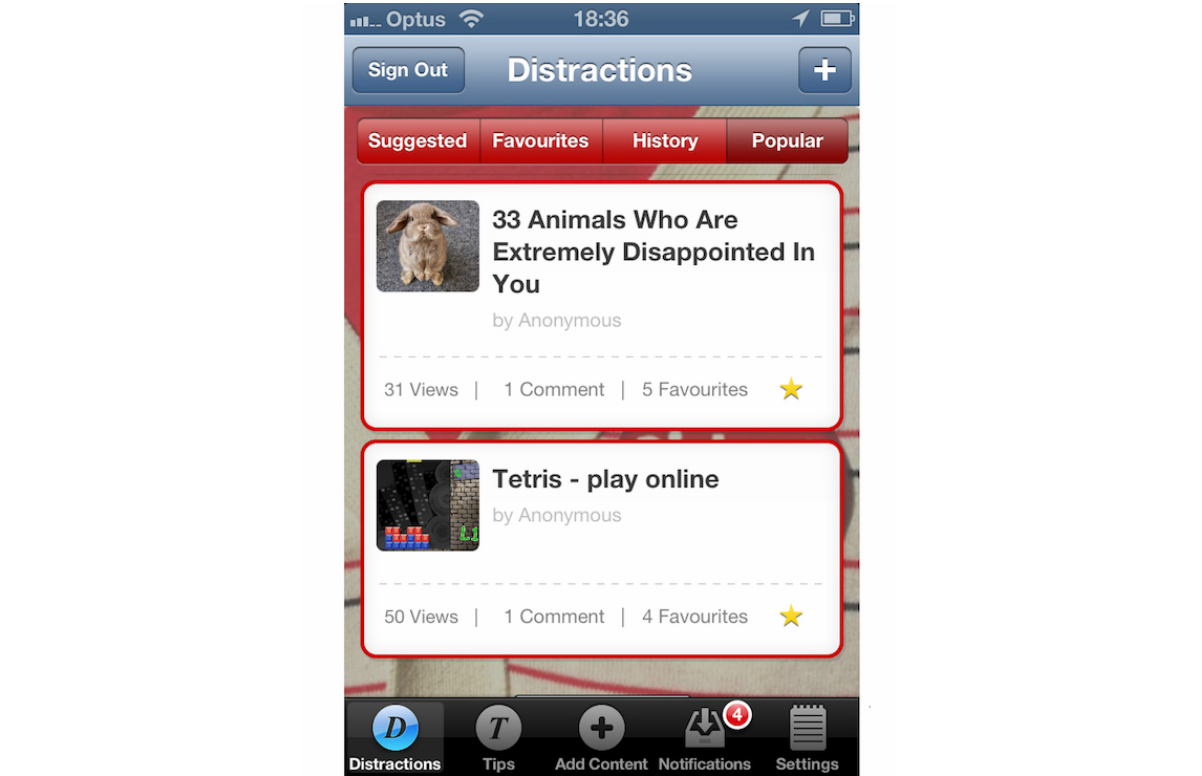
Figure 1. DistractMe includes a scrollable list of distractions. The red circle in the navigation bar highlights notifications of responses from other